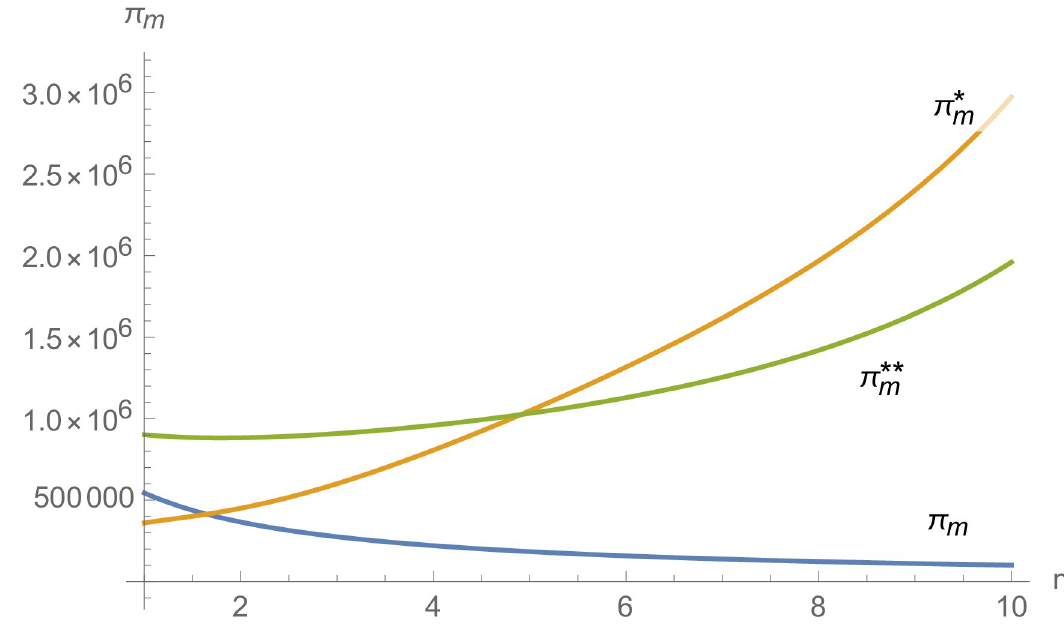
Fig 37. The impact of n on π m